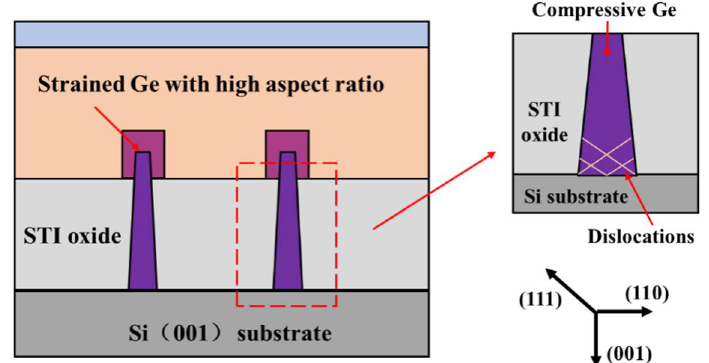
Figure 1. The targeted structure with compressive Ge grown on the high-aspect-ratio trench. During the growth of Ge on Si-fins in the epitaxy module, a two-step growth strategy is adopted. Firstly, a very thin layer is introduced at a low temperature to reduce defects. This buffer layer provides extra nucleation centers for dislocations originating from the big lattice mismatch between Si and Ge. This initial layer effectively assists in decreasing the possibility of 3D island accumulation [39–41]. The subsequent growth at high temperatures accelerates the rate of defect motion, which ultimately facilitates annihilation during material